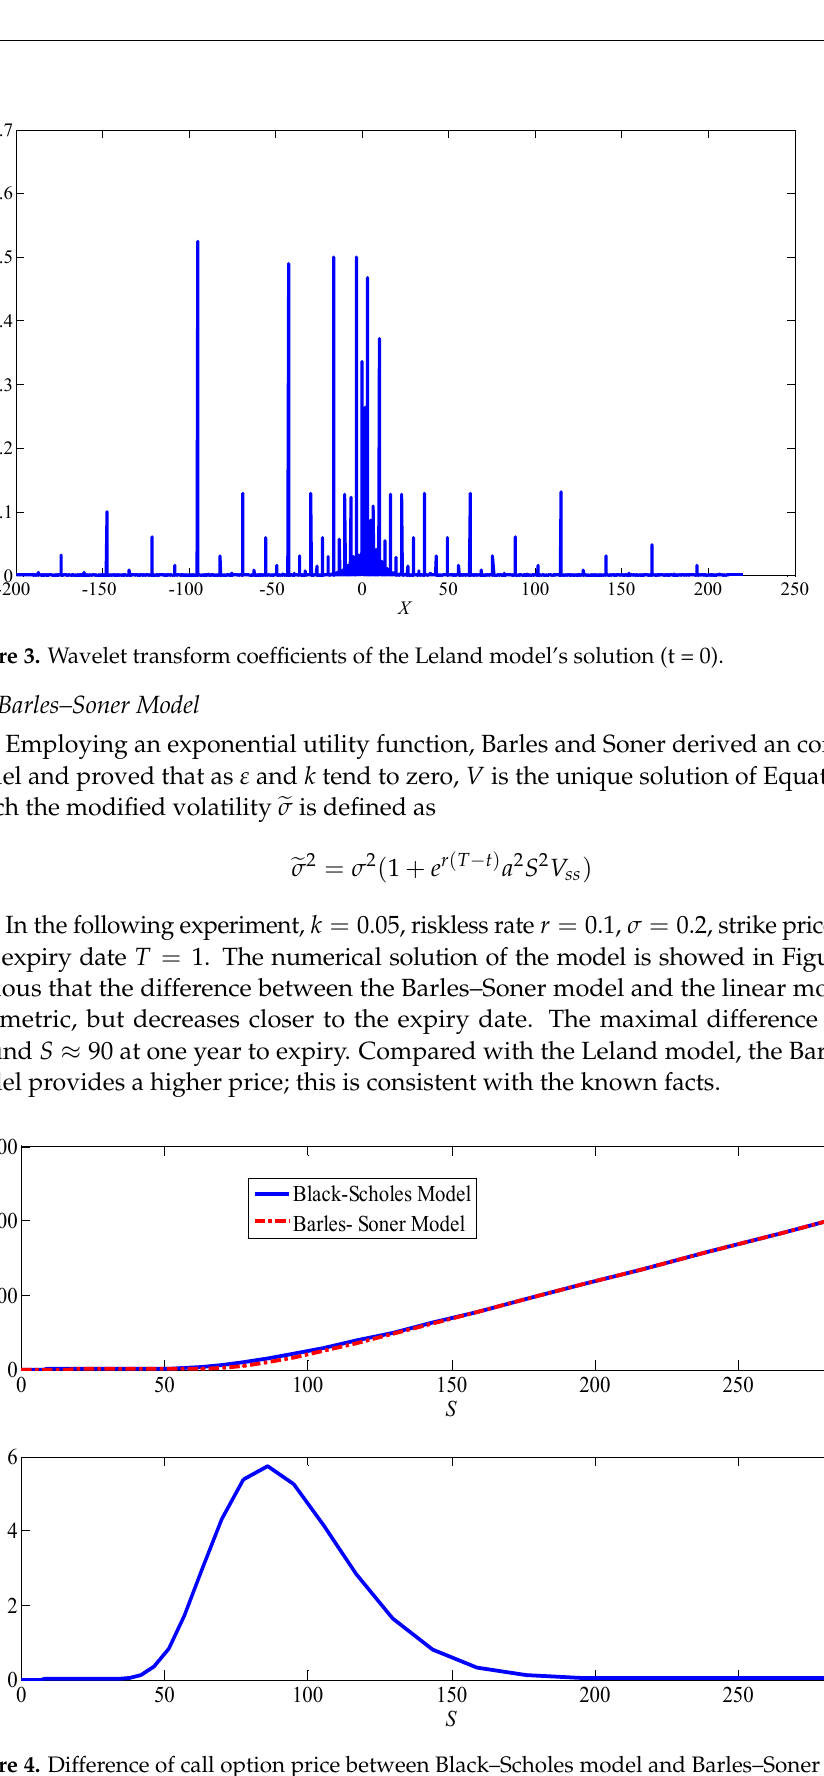
Figure 4. Difference of call option price between Black–Scholes model and Barles–Soner model.